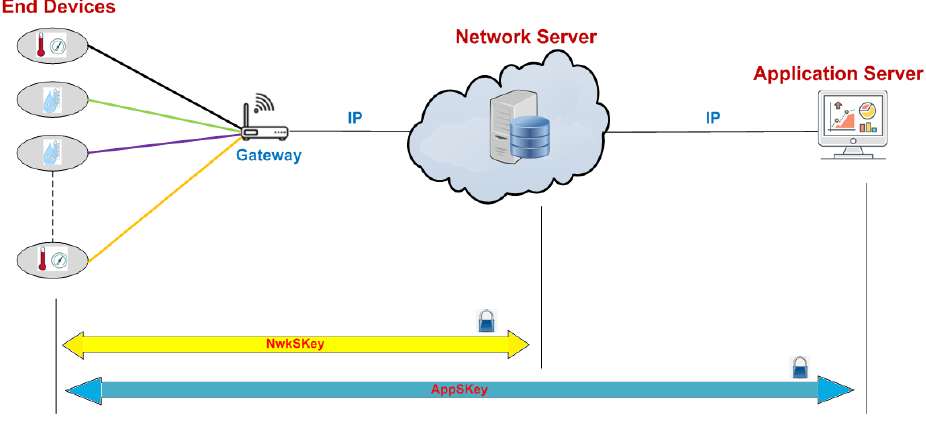
Figure 6. LoRaWAN